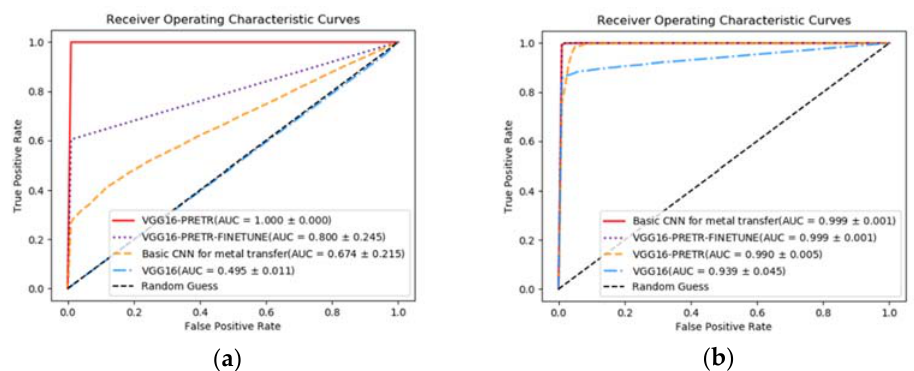
Figure 9. ( a ) ROC curves for detecting abnormality with original image; ( b ) ROC curves for detecting abnormality with preprocessed image.